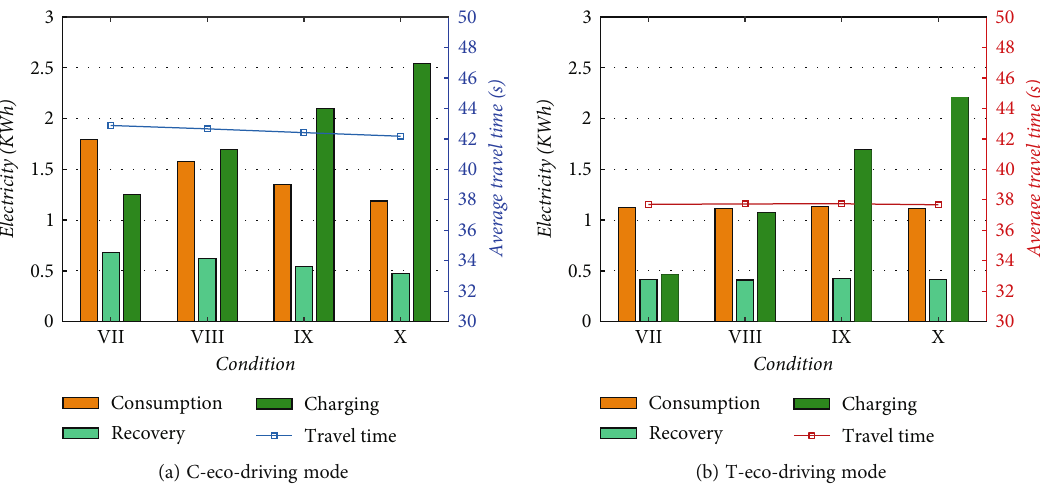
Figure 7: Electricity usage (consumption, recovery, and charging) and average travel time under four conditions (VII ~